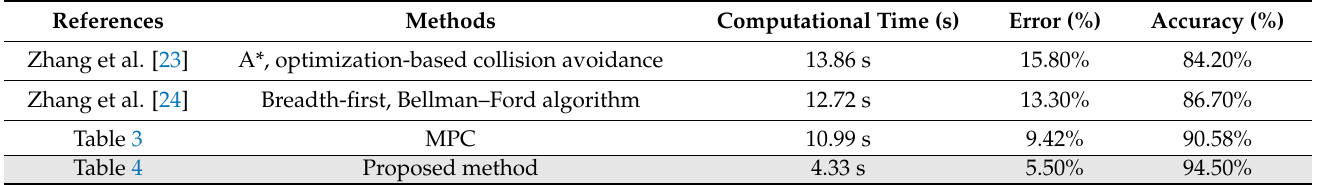
Table 6. Comparison of experimental results between proposed ARP system and existing